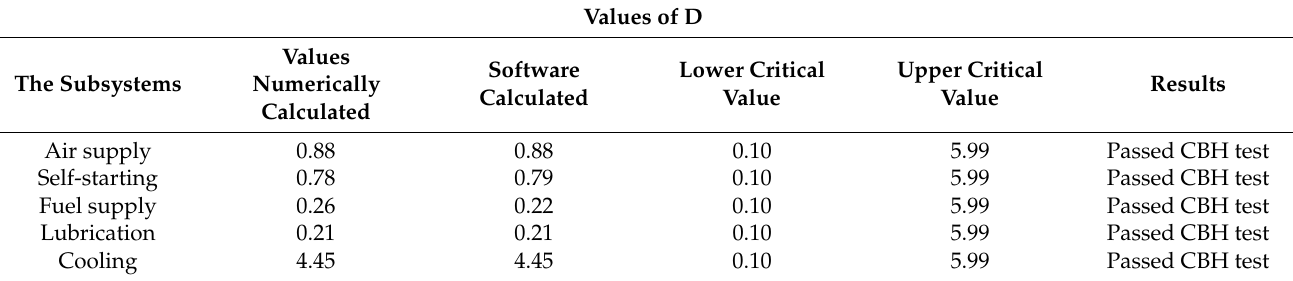
Table 4. CBH test values of all five